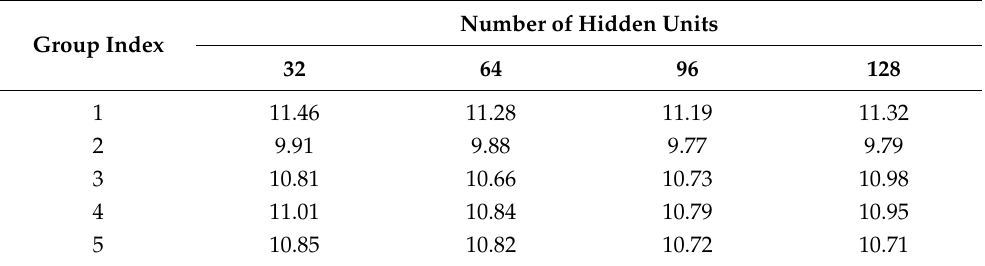
Table 6. RMSE of different network parameters (units: m).